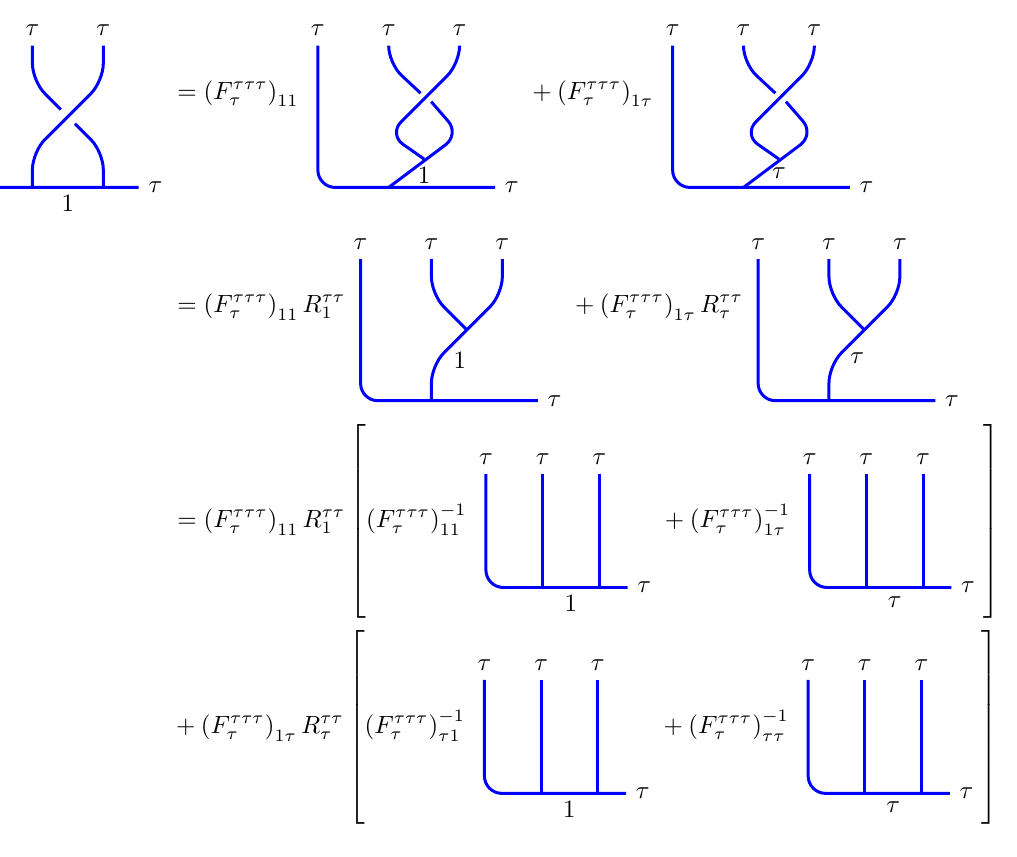
Figure 13 . Action of σ 2 ∈ B 3 on the fusion basis vector | 1 i . The elements of the F -matrix are in